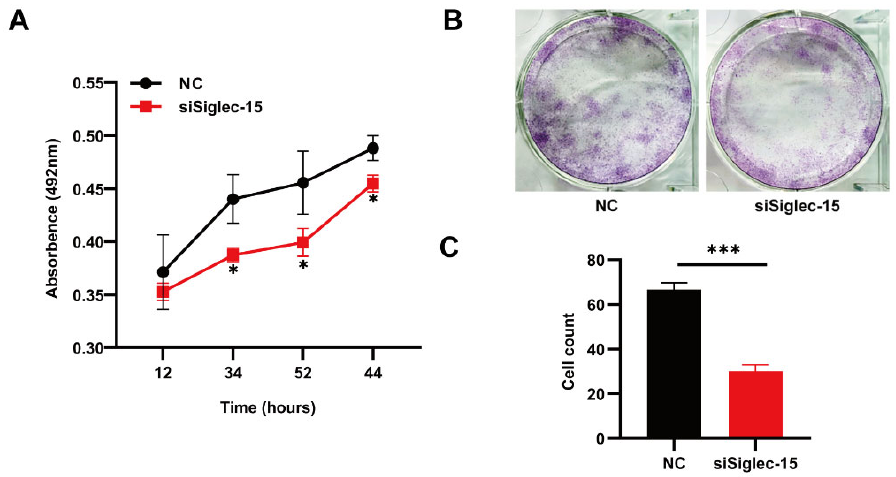
Figure 4. The effect of Siglec-15 silencing on the proliferation and colony formation of GCTB stromal cells. ( A ) The viability of Hs737.T cells transfected with siRNA were detected by the MTS method. ( B , C ) Clone experiments showed colony formation of Hs737. T cells. The numbers of Hs737. T cell clones in the siSiglec-15 group were significantly fewer than those in the NC group. * p < 0.05, *** p < 0.001.